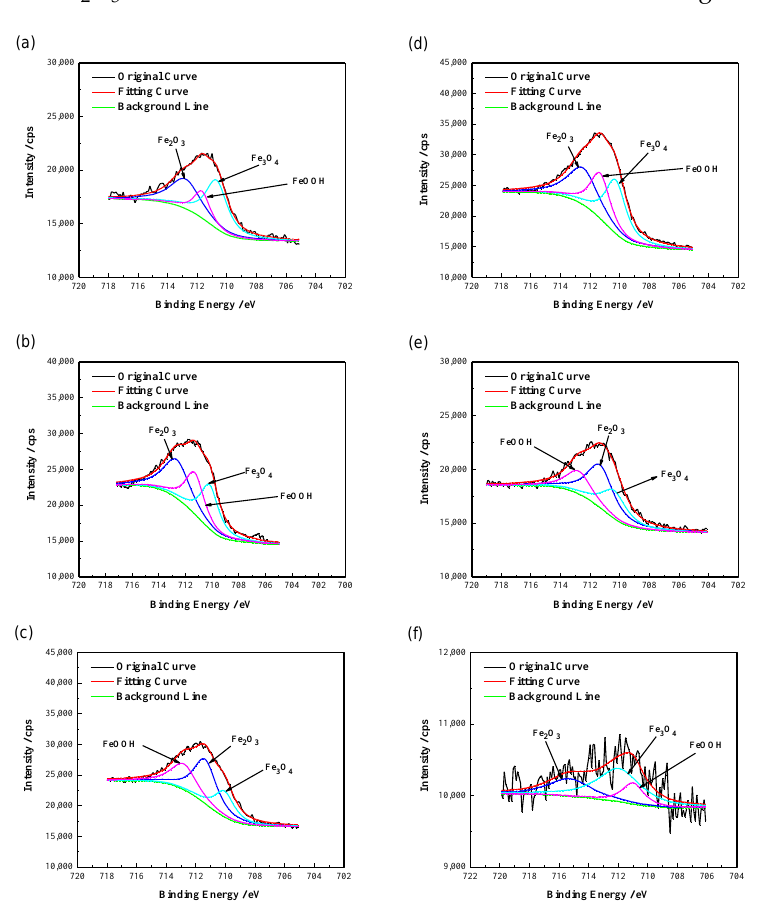
Figure 2. High resolution Fe spectra of corrosion products under the aerobic conditions with 0 ppm ( a ), 50 ppm ( b ), 100 ppm ( c ) and anaerobic conditions with 0 ppm ( d ), 50 ppm ( e ), 100 ppm ( f ).